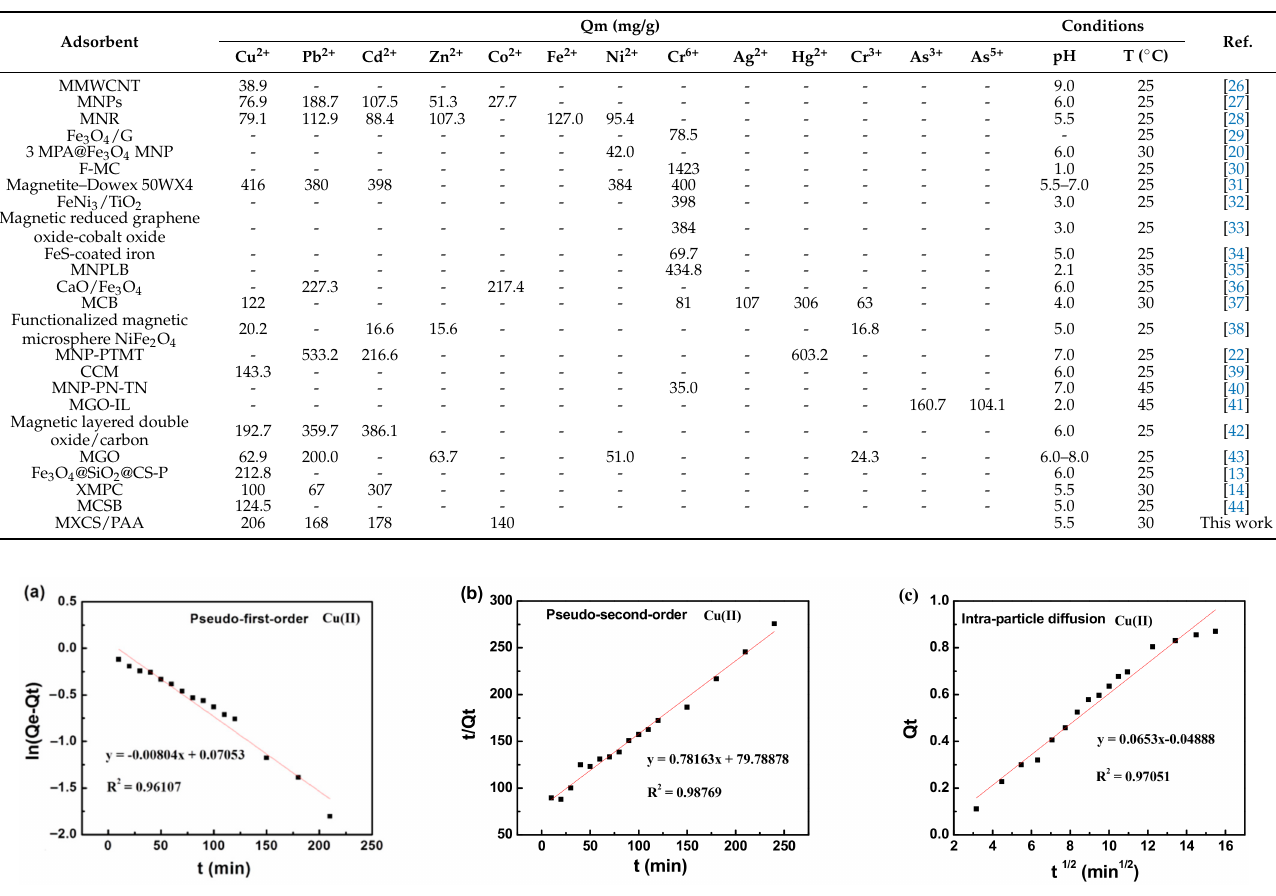
Table 1. Adsorption of heavy metal from wastewater using magnetic adsorbents.